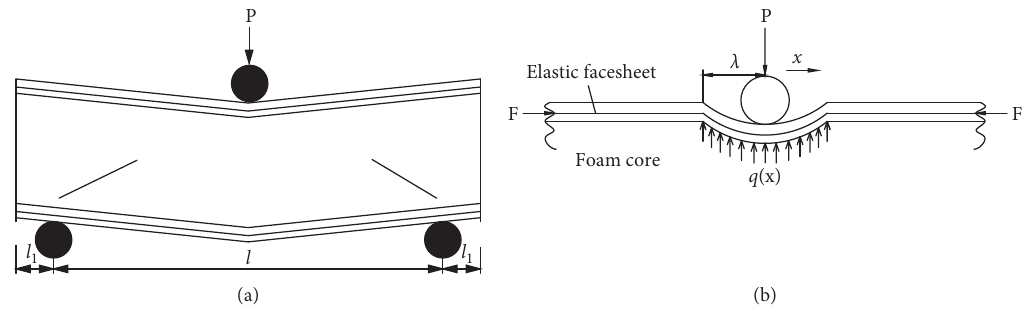
Figure 11: Failure types of TFS sandwich structures: (a) core shear failure and (b) indentation. Table 5: Comparison of experimental and analytical results.